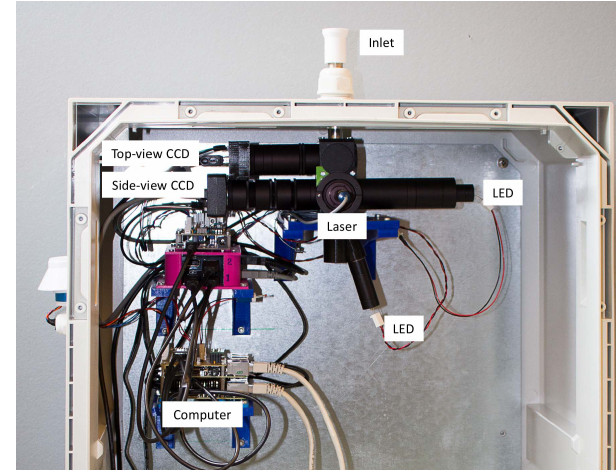
Figure 3. Photograph of D-ICI (door of enclosure is